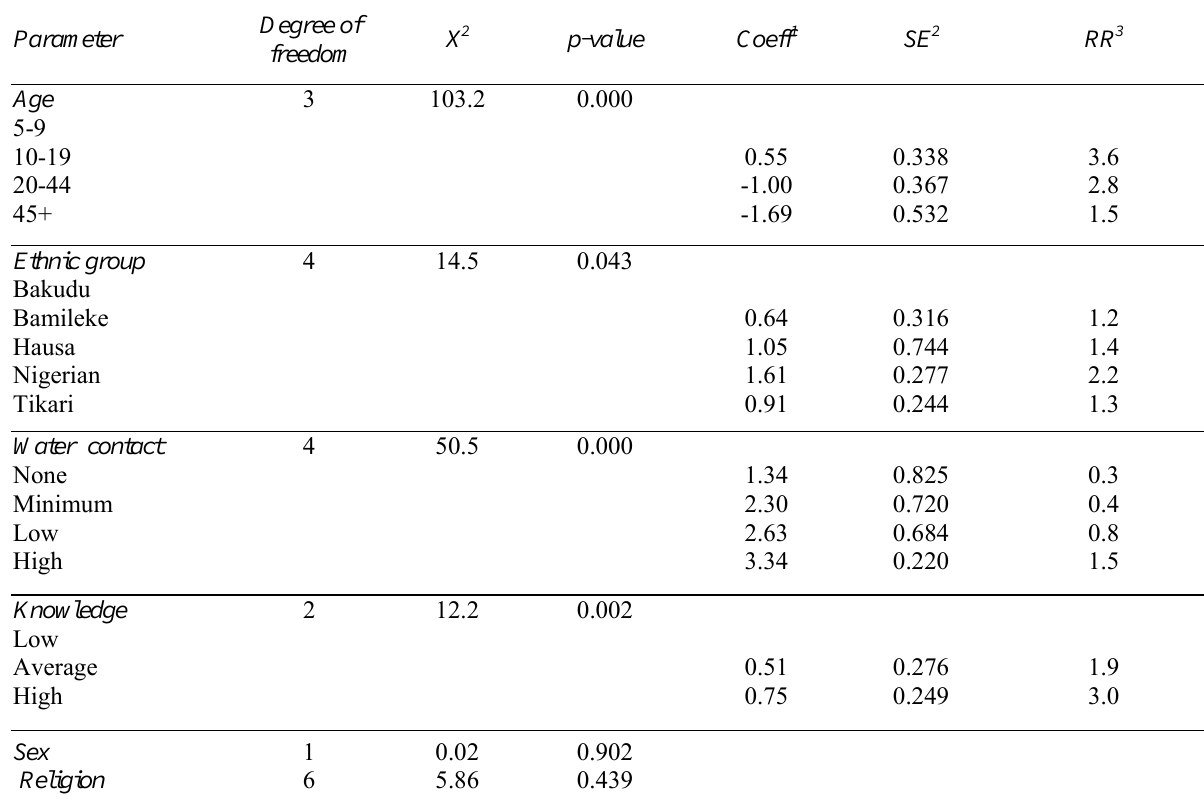
Table 4: Stepwise logistic regression of predictors of